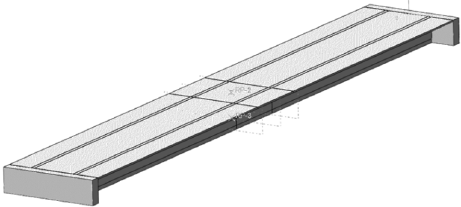
Figure 3. Finite element model of the box girder.